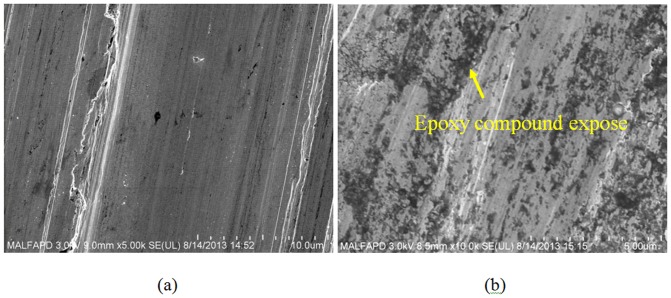
Abrasion test images.(a) TiO2 and (b) PEI inks.